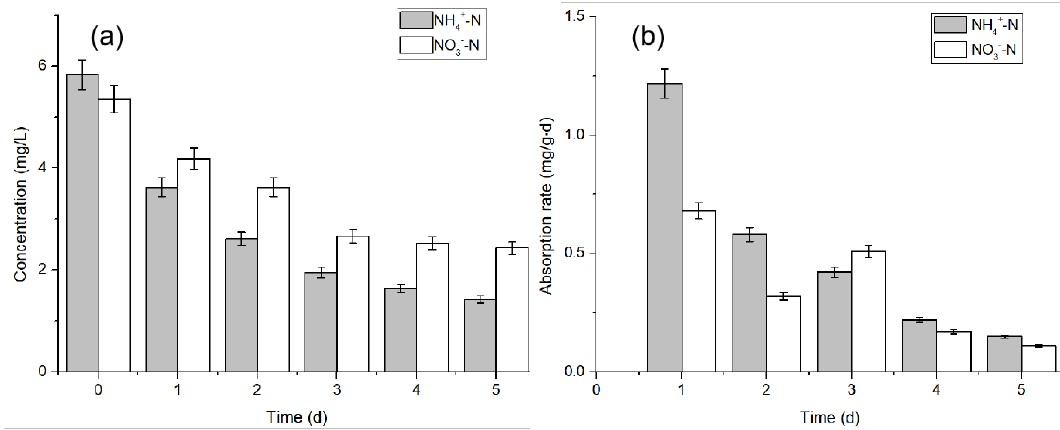
Figure 5. Changes of nitrogen (NH 4 + -N and NO 3 − -N) concentration and absorption rate, ( a ) Changes of nitrogen concentration (NH 4 + -N and NO 3 − -N) in the culture medium, ( b ) Changes of nitrogen absorption rate (NH 4 + -N and NO 3 − -N) by water spinach.